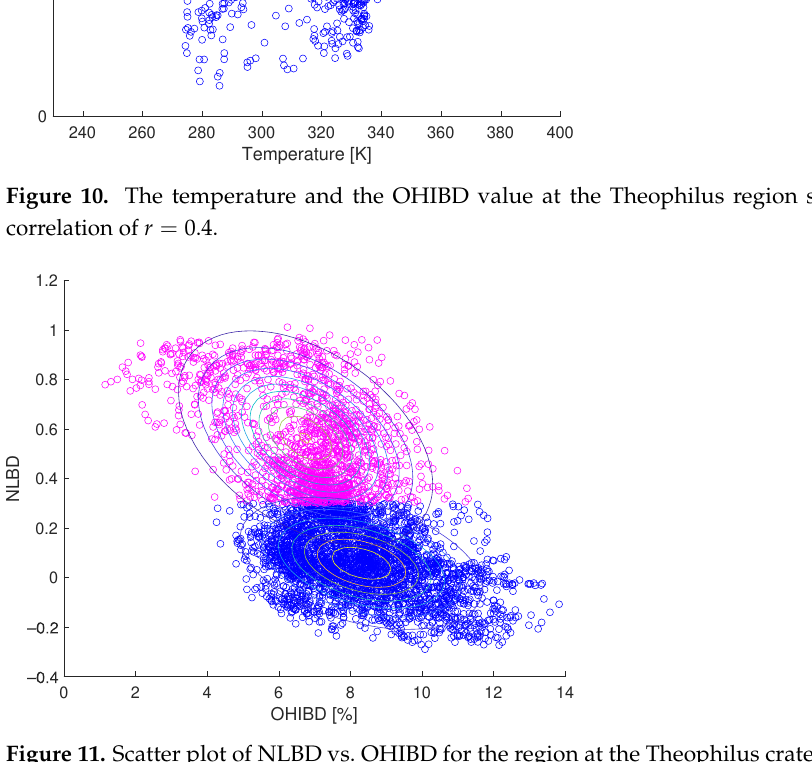
Figure 11. Scatter plot of NLBD vs. OHIBD for the region at the Theophilus crater. The correlation coefficient for all pixels with an NLBD value larger than 0.3 (magenta circles) is r = − 0.436. For the pixels with an NLBD value below 0.3 (blue circles), it is r = −